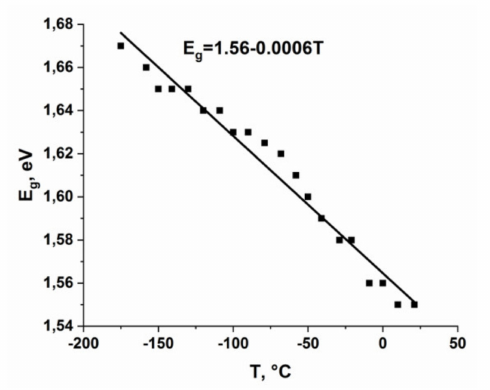
Figure 4. Temperature dependence of the d z2 → d x2 -y2 transition energy (points) and its linear approximation (solid line). The graph shows the equation of a straight line that describes the experimental points in the best possible